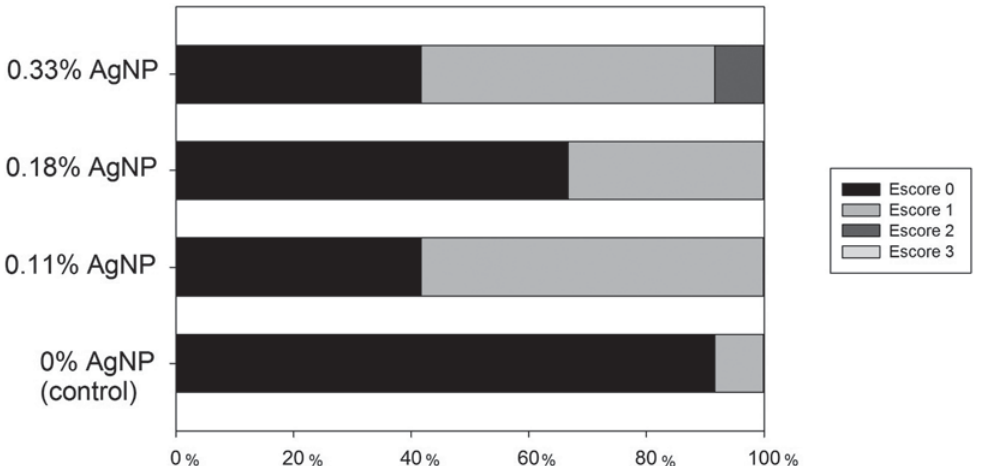
Figure 3- (cid:3)(cid:36)(cid:71)(cid:75)(cid:72)(cid:86)(cid:76)(cid:89)(cid:72)(cid:3)(cid:85)(cid:72)(cid:80)(cid:81)(cid:68)(cid:81)(cid:87)(cid:3)(cid:76)(cid:81)(cid:71)(cid:72)(cid:91)(cid:3)(cid:11)(cid:36)(cid:53)(cid:44)(cid:12)(cid:3)(cid:86)(cid:70)(cid:82)(cid:85)(cid:72)(cid:17)(cid:3)(cid:39)(cid:72)(cid:70)(cid:85)(cid:72)(cid:68)(cid:86)(cid:72)(cid:71)(cid:3)(cid:68)(cid:80)(cid:82)(cid:88)(cid:81)(cid:87)(cid:3)(cid:82)(cid:73)(cid:3)(cid:68)(cid:71)(cid:75)(cid:72)(cid:86)(cid:76)(cid:89)(cid:72)(cid:3)(cid:85)(cid:72)(cid:80)(cid:68)(cid:76)(cid:81)(cid:72)(cid:71)(cid:3)(cid:82)(cid:81)(cid:3)(cid:87)(cid:75)(cid:72)(cid:3)(cid:87)(cid:82)(cid:82)(cid:87)(cid:75)(cid:3)(cid:90)(cid:76)(cid:87)(cid:75)(cid:3)(cid:19)(cid:8)(cid:3)(cid:36)(cid:74)(cid:49)(cid:51)(cid:17)(cid:3)(cid:49)(cid:82)(cid:3) statistical difference was found